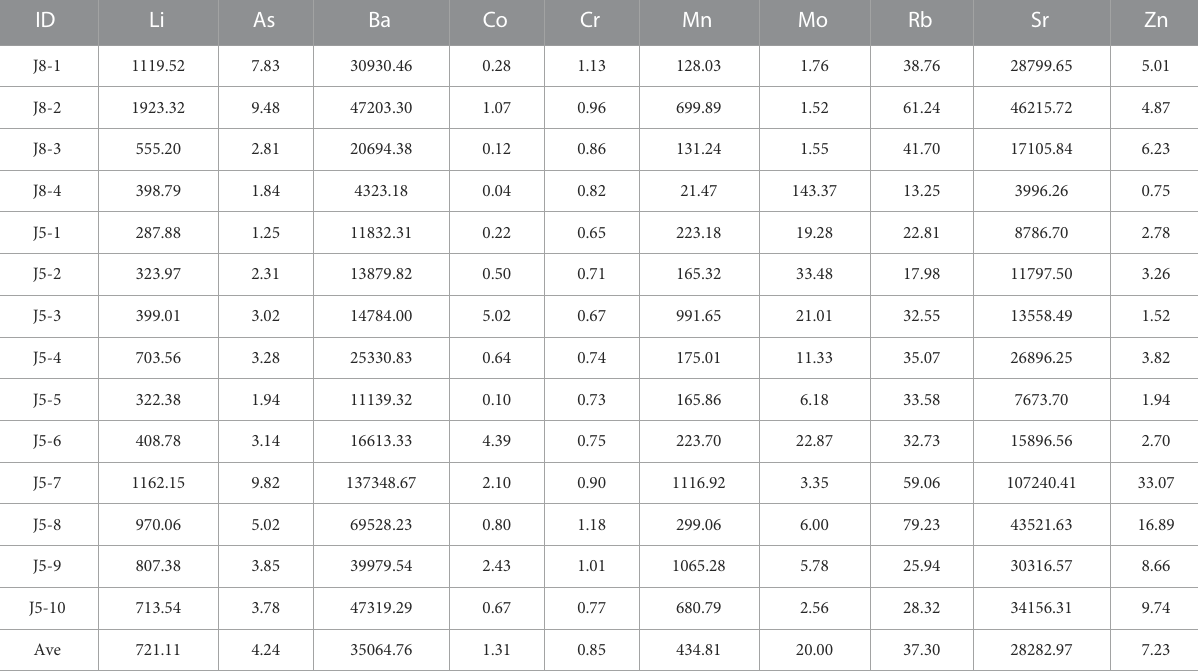
TABLE 3 Results of trace element concentration of coalbed-produced water in the Linfen mining area (unit, μ g/L). ID Li As Ba